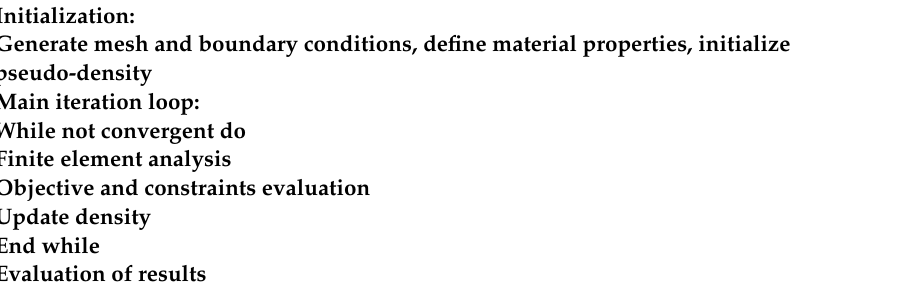
Algorithm 1 SIMP algorithm for topology optimization. SIMP